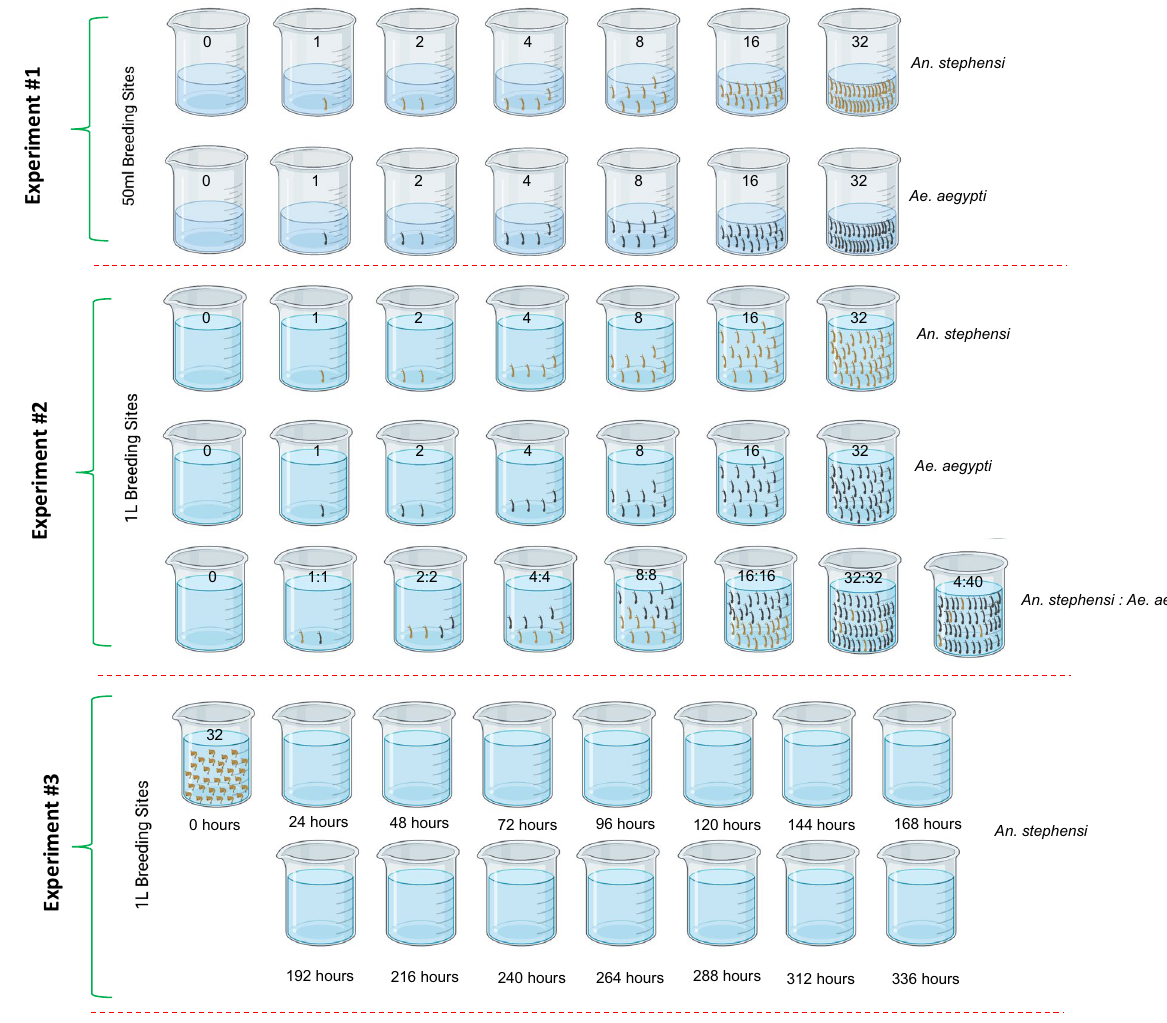
Figure 1. Design of experiments to investigate the impact of different environmental conditions on An. stephensi and Ae. aegypti eDNA detection. Numbers of second instar larvae are denoted on each artificial breeding site. Experiment 1 investigated eDNA detection of different densities of An. stephensi and Ae. aegypti in 50 ml artificial breeding sites. Experiment 2 investigated eDNA detection of different densities of An. stephensi and Ae. aegypti in 1L artificial breeding sites, including different ratios of An. stephensi:Ae. aegypti co-habiting the same breeding site. Experiment 3 investigated the rate of eDNA degradation. An. stephensi pupae were left in each breeding site for 24 h, prior to manual removal of all emerged adults, remaining pupae, and pupal skins; eDNA detection was performed for the following 14 days. Figure created with